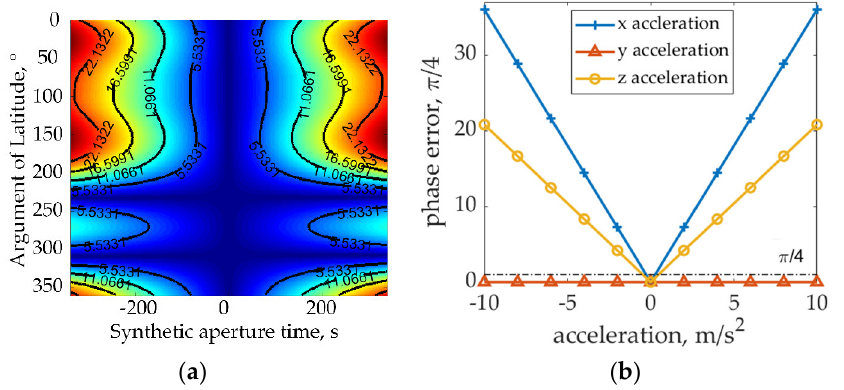
Figure 4. Phase error analysis for CF-SAR in specific cases. ( a ) Phase error of ‘stop-go’ assumption for spaceborne CF-SAR. ( b ) Phase error of ‘constant-baseline’ assumption for airborne CF-SAR.